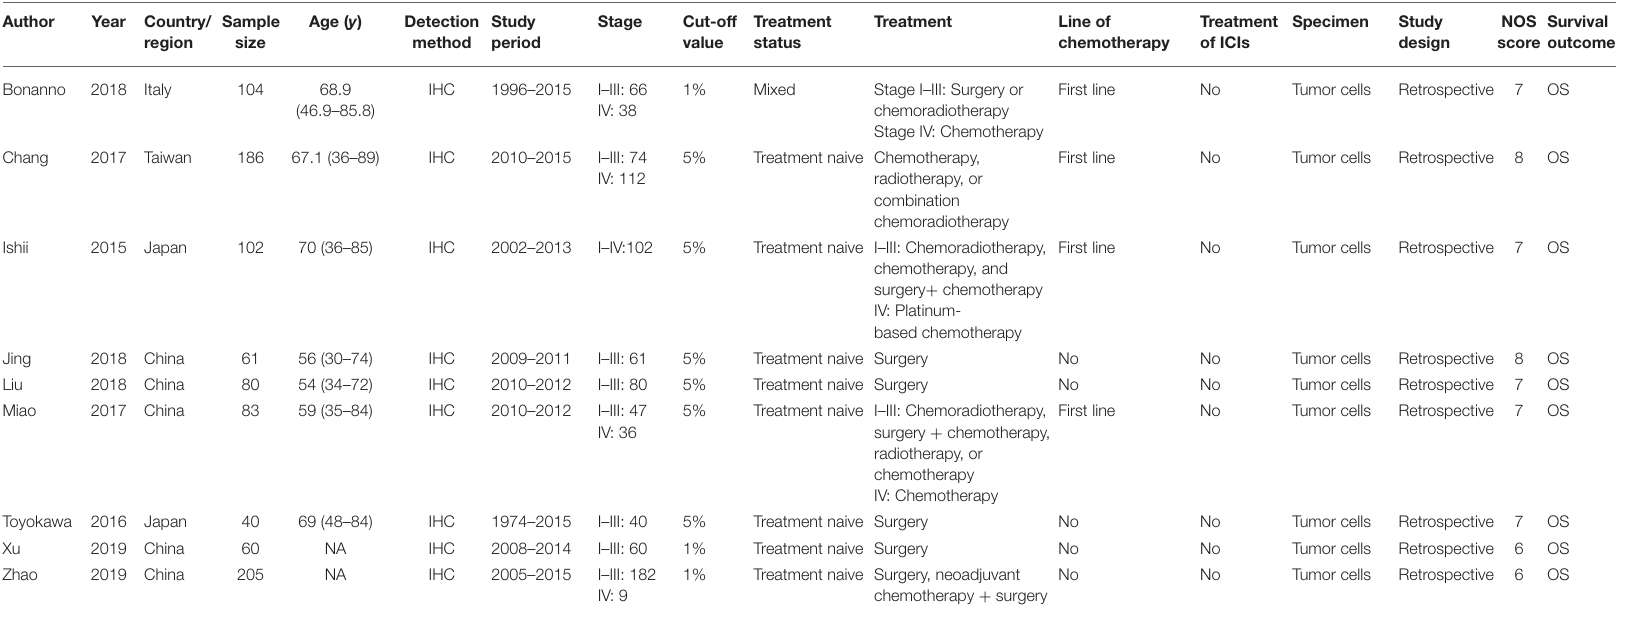
TABLE 1 | Basic characteristics of included